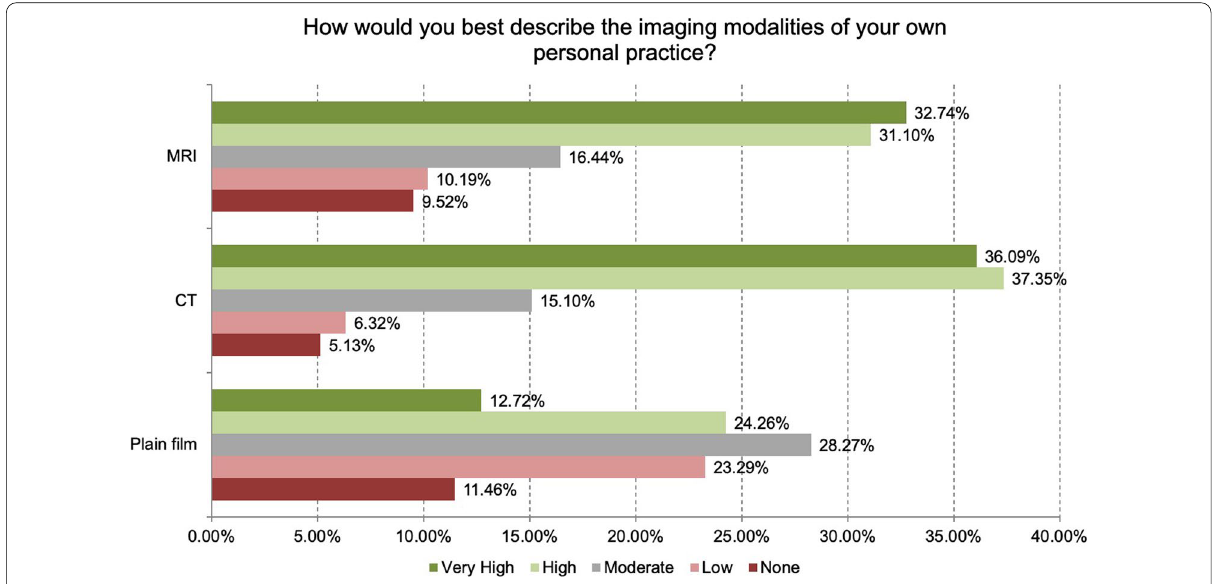
Fig. 7 Range of modalities used in the respondents’ personal practice (responses n Table 2 How would you best describe your own "organ-based or clinical" areas of practice? (responses n